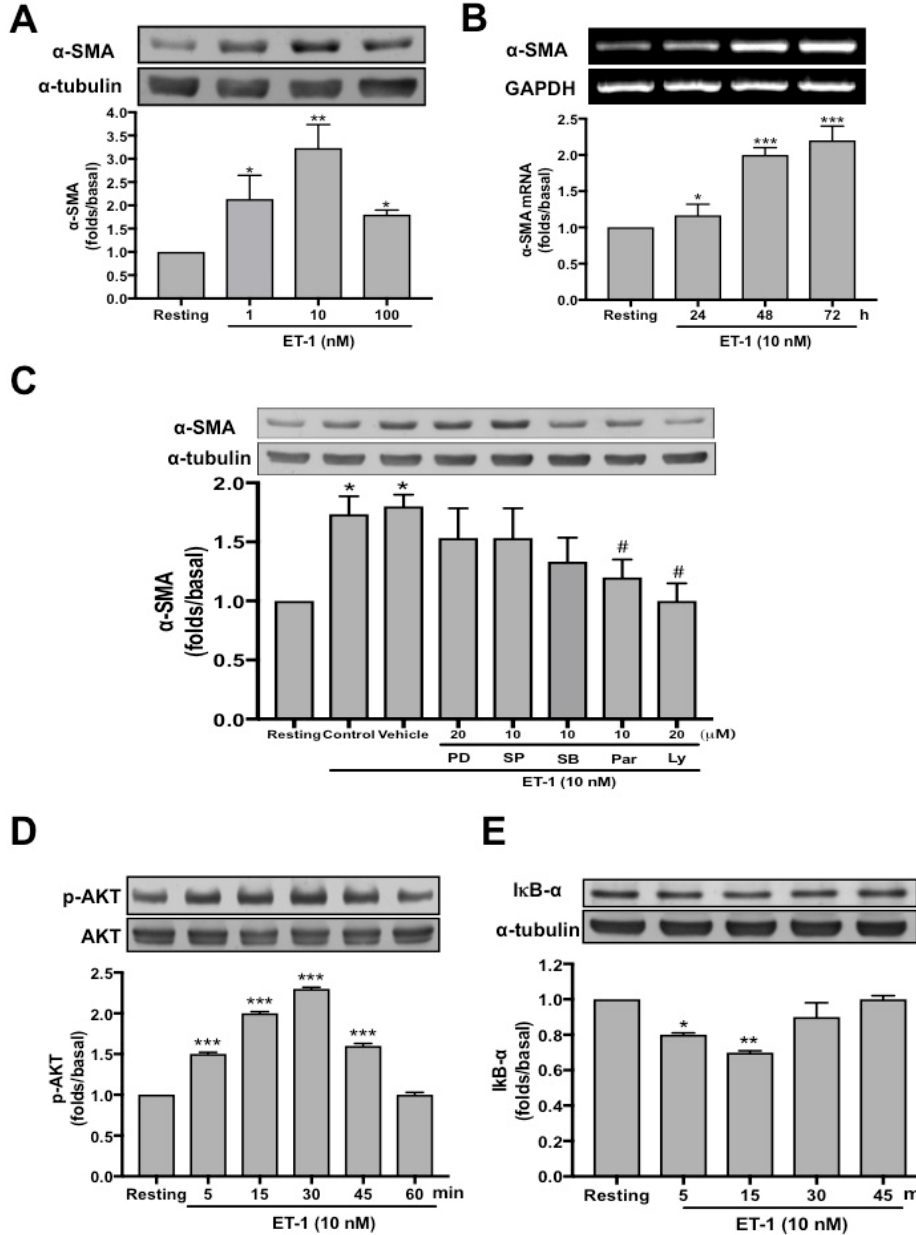
Figure 6. ET ‐ 1 − induced α‐ SMA expression in human PMCs is PI3K/AKT and NF ‐κ B dependent. ( A ) Primary human PMCs were treated with or without (resting) the indicated concentration of ET ‐ 1 for 72 h, and α‐ SMA was analyzed by Western blotting. ( B ). Primary human PMCs were treated with ET ‐ 1 10 nM for the indicated times, and the mRNA expressions of α‐ SMA were analyzed by semiquantitative reverse transcriptase PCR. ( C ) MeT ‐ 5A cells were preincubated with the vehicle, PD98059 (PD, 20 μ M), SP600125 (SP, 10 μ M), SB203580 (SB, 10 μ M), Parthenolide (Par, 10 μ M) or LY294002 (LY, 20 μ M), then ET ‐ 1 was added for 24 h, and α‐ SMA was analyzed by Western blotting. ( D, E ) MeT ‐ 5A cells were treated without (resting) or with ET ‐ 1 10 nM for the indicated times, and phosphorylated AKT, total AKT or I κ B ‐α were analyzed by Western blotting. The relative folds of densitometric data were expressed as the mean ± SD of three independent experiments. * p < 0.05,